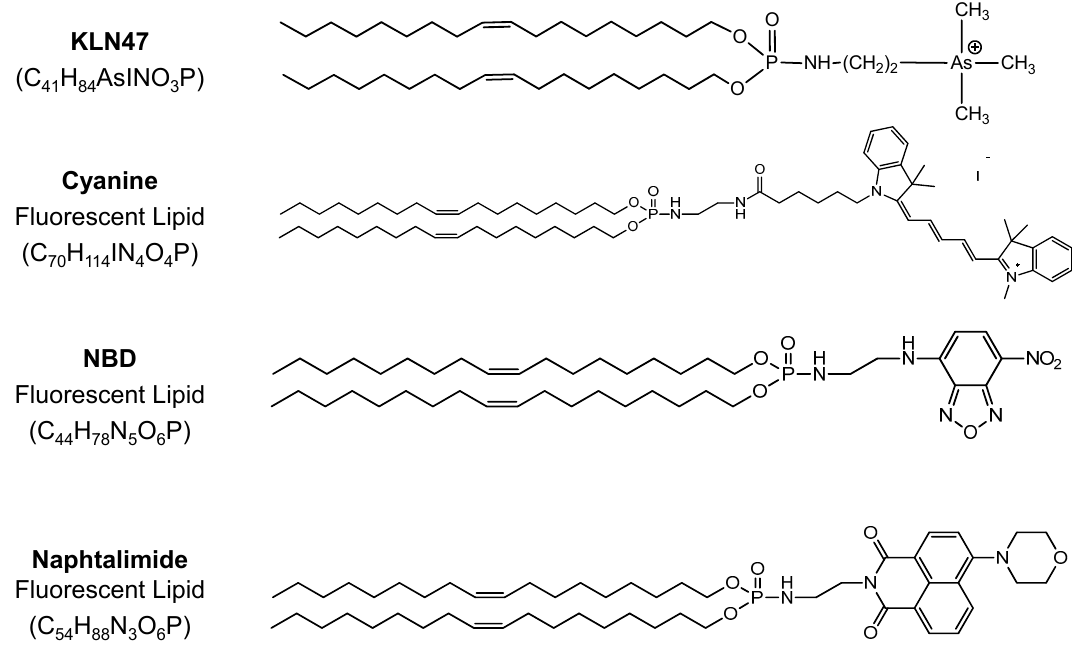
Figure 1. Chemical Structures of lipophosphoramidate KLN47 and fluorescent lipids. Table 1. Chemical characteristics of fluorescent cationic lipids.